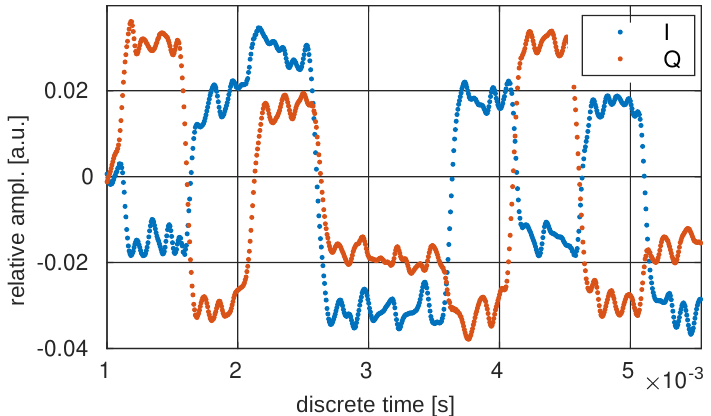
Figure 7. IQ signals before integration taken from the microcontroller thanks to the HITL